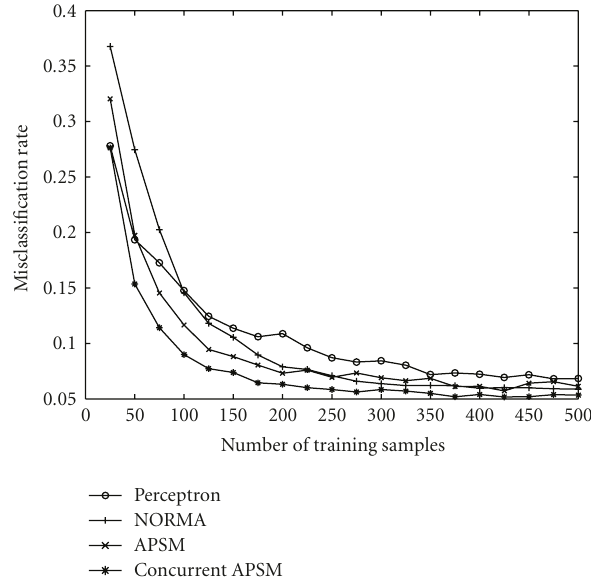
Algorithm 3: Proposed algorithm.